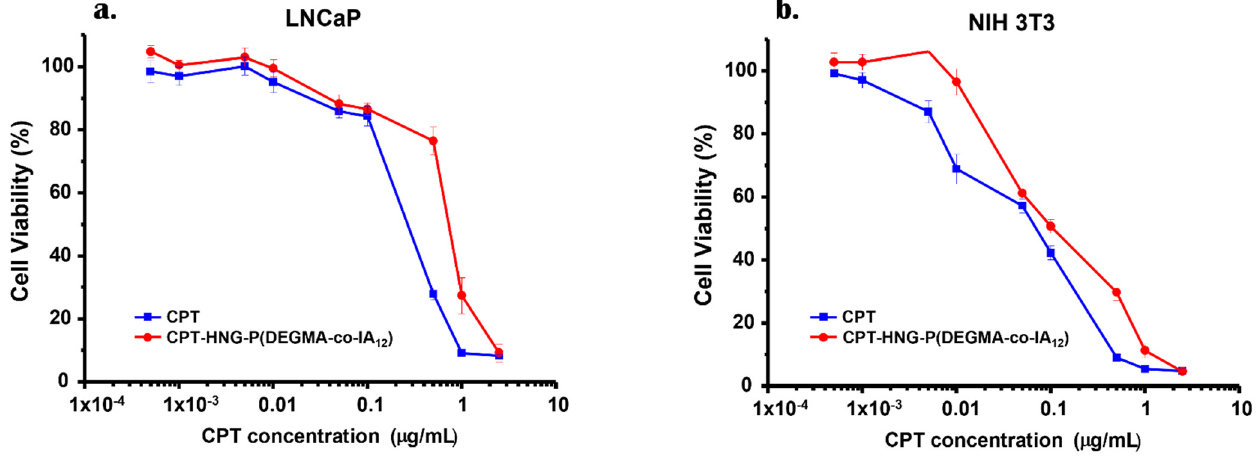
Figure 7. MTS cell viability assays in LNCaP ( a ) and NIH 3T3 ( b ) cell lines. Cell viability data are expressed as mean ± SEM (n = 3). Table 5. IC 50 values of CPT and different CPT loaded HNG-P(DEGMA-co-IA 12 ) obtained over LnCaP and NIH 3T3 cell lines.